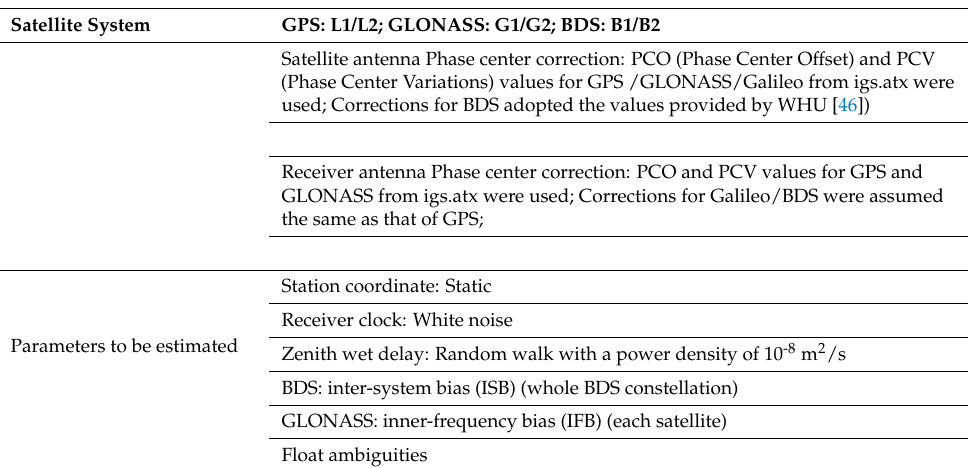
Figure 3. The statistics of Bartlett test and iterations under two conditions with elevation angle masks of 10° and 15°, respectively, over the experimental period of Doy 303 to 317, 2015. 4.2. Internal/External Accuracy Testing The slant wet delays of six stations (XIUW, BAIY, YONG, QINZ, QINY and KAIY) for the data of Doy 303 to 317, 2015 were used to validate the internal/external accuracy of the proposed method based on the tomographic modeling established in Section 2.1. For the internal accuracy testing, six stations are both used to reconstruct the atmosphere wet refractivity, two elevation angle masks of 10° and 15° were both selected for the two schemes. The residuals of tropospheric delay in the two schemes are shown in Figure 4, where the top and bottom represent the case of 10° and 15° of elevation masks, separately. It is clearly seen that the residual of the proposed method (Scheme 2) is smaller than that of conventional method (Scheme 1) for two cases. The Root Mean Square (RMS) error and the mean bias (Bias) for schemes 1 and 2 are 3.0/−0.3 mm and 2.3/0.1 mm, respectively, under the condition of 10° elevation angle mask while those values are 2.9/−0.2 mm and 2.1/0.1 mm, respectively, under the condition of 15° elevation angle mask. In addition, Figure 5 also gives the change of slant wet delay residuals with elevation angle for two schemes under different elevation angle masks. It is clear that the residuals decreased with ascending elevation angles. The residuals of Scheme 2 (red dots) are obviously smaller than those in Scheme 1 (blue dots) for two cases of 10° and 15° of elevation angle masks.